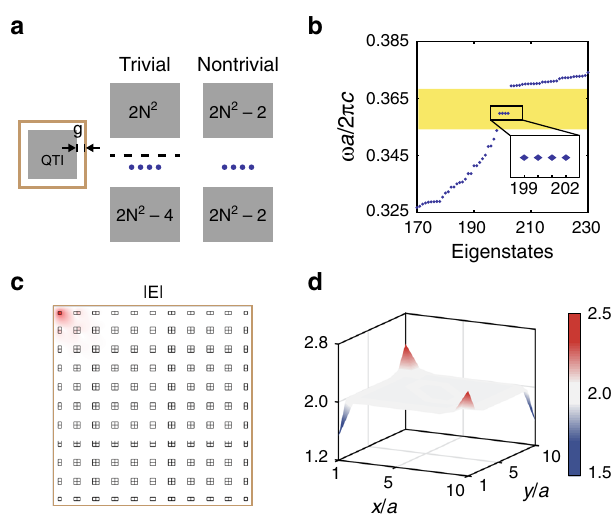
Fig. 4 Topologically protected corner states and fi lling anomaly in a 2D system. a For a fi nite PhC with N × N unit cells enclosed by PECs, the counting of the number of eigenstates below and above an energy gap are distinct between quadrupole and trivial phases. b Eigenstates of a 10 × 10 quadrupole PhC, showing four degenerate corner states inside the bulk gap, shaded in yellow. c Mode pro fi le ( ∣ E z ∣ ) of one of the corner states. d Spatial distribution of the accumulative electromagnetic energy density for the lowest 200 energy eigenstates in the quadrupole PhC, showing fractional occupations (2 ± 0.5) at the